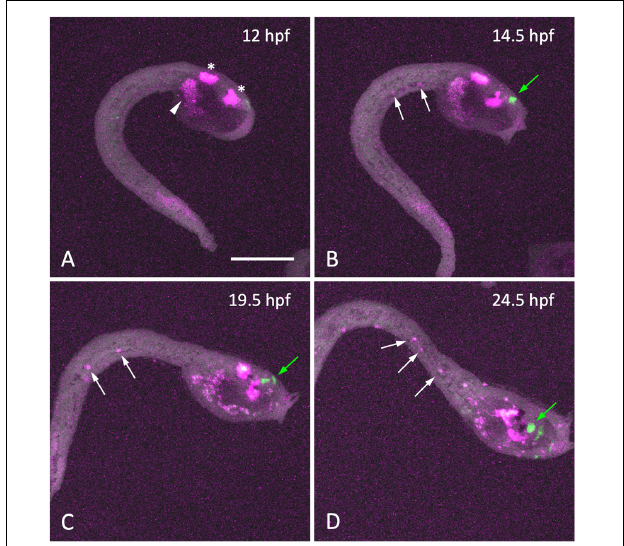
FIGURE 5 | Migration of mesenchyme cells along the endodermal strand during larval development. (A–D) Time-lapse fluorescent images of a late-tailbud embryo expressing Kaede under the control of the cis -regulatory region of Pax2/5/8.a at the time indicated. Kaede fluorescence was photo-converted from green to red (shown in magenta) by 405-nm laser irradiation at 12 hpf (A) . At 12 hpf, photo-converted Kaede fluorescence was observed in the central nervous system ( asterisks ) and mesenchyme cells ( arrowhead ) in the trunk region, whereas no cells were labeled in the tail region. As development proceeded (B–D) , a few cells labeled with photoconverted-Kaede appeared in the tail region and posteriorly migrated along the endodermal strand ( white arrows ). Cells synthesized Kaede after photo-conversion were labeled with green fluorescence ( green arrows in panels B–D) . Scale bar, 100 µ m.